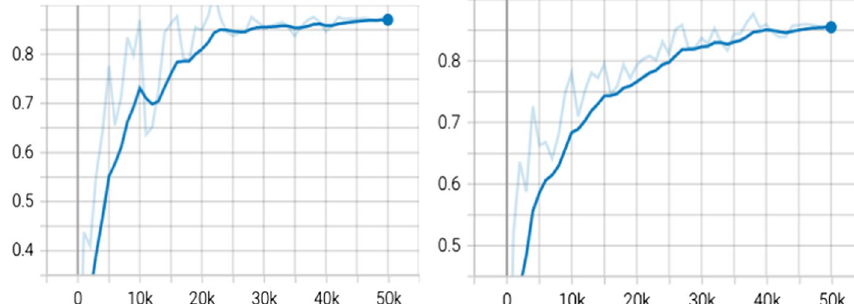
Fig. 15 Precision (left) and recall (right) curves for the batch of test images compiled from images taken with the two research vehicles. The faded curves presents the exact plot values while the darker colour correspond to the averaged (smoothed)